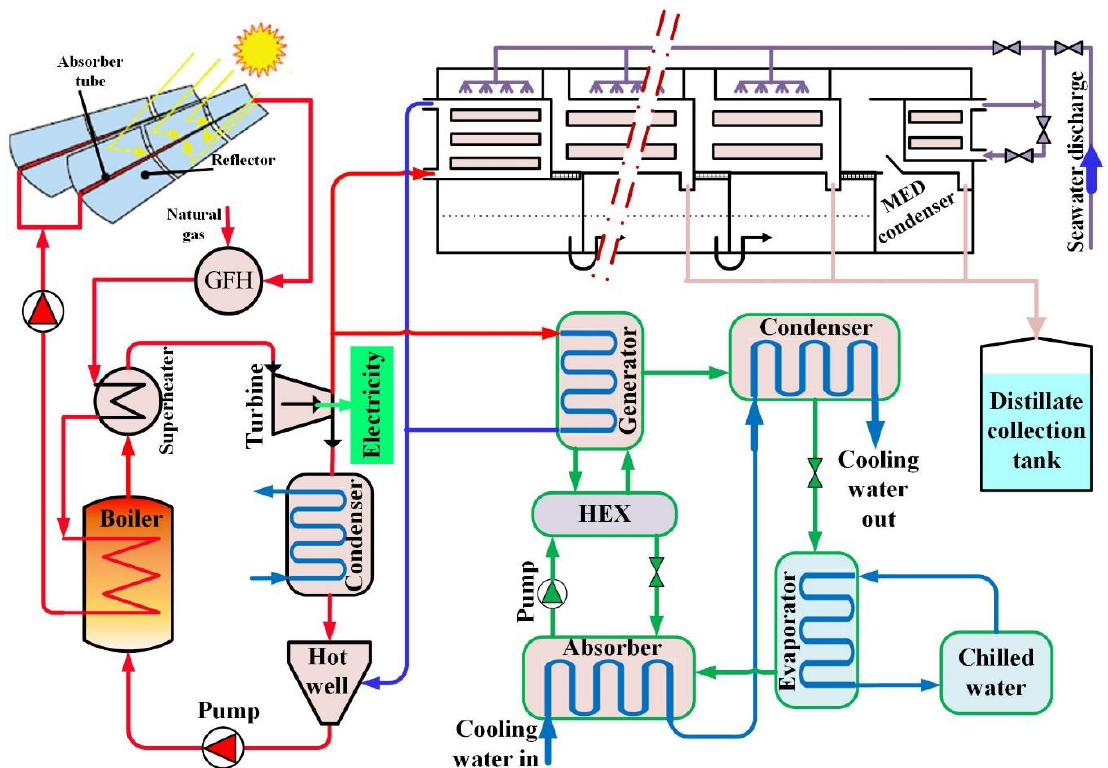
Figure 12. The hybrid SPS-ABR-MED system (adapted from [113]).